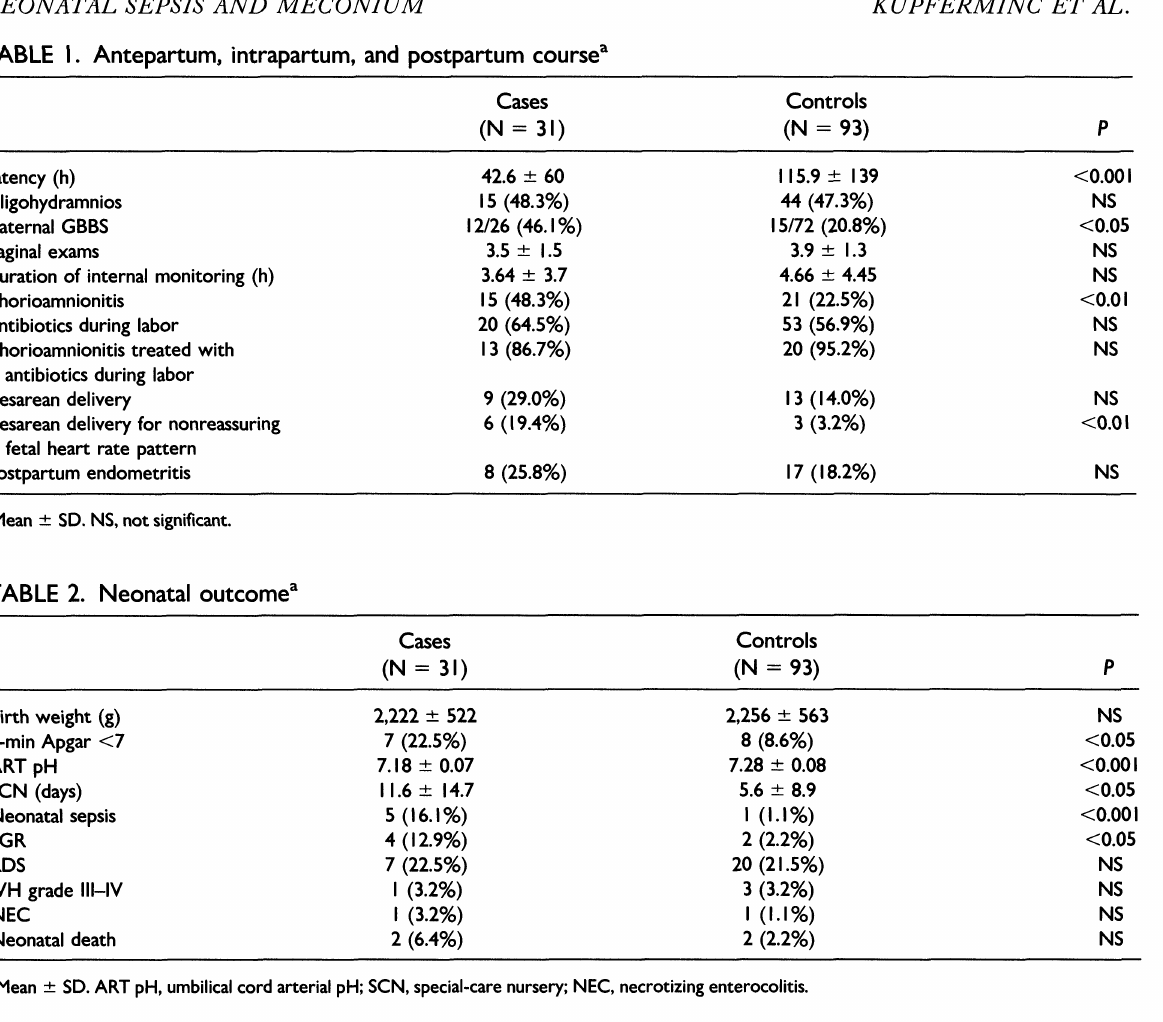
TABLE I. Antepartum, intrapartum, and postpartum course a